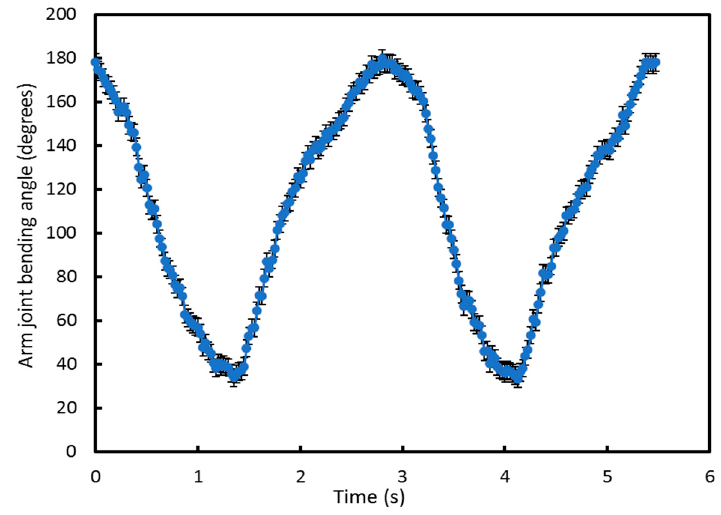
Figure 8. Initial arm joint bending angle measurement results using the e-textile to identify the movement limits.